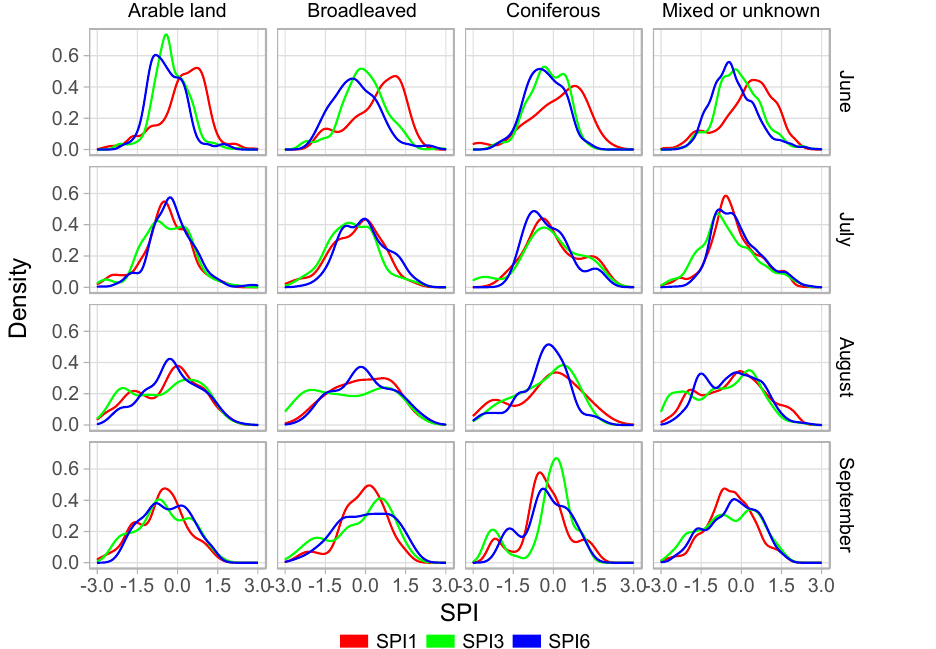
Figure 8. The distribution of SPI values for different land uses 1 month before VCI drops below 20.